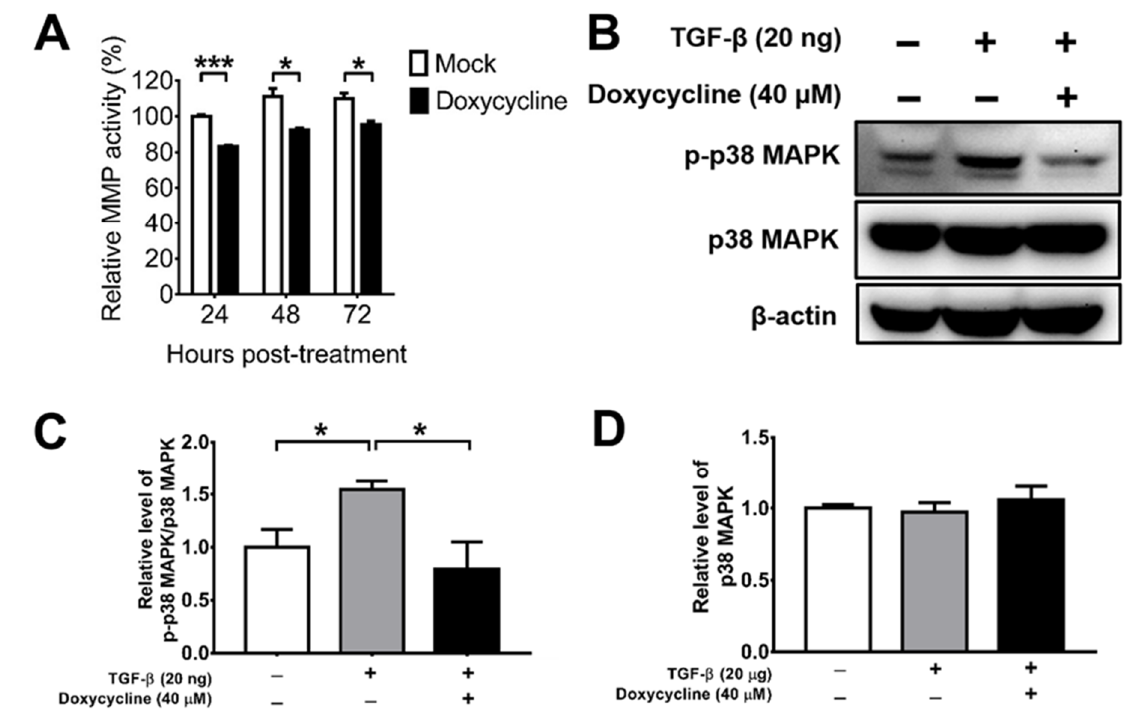
Figure 2. Doxycycline inhibits the total MMP activity and p38 MAPK activation of ARPE-19 cells. ( A ) ARPE-19 cells were treated with or without doxycycline (10 μM) and harvested at the indicated times to assay the total MMP activity. The value of cells without drug treatment for 24 h was set as 100%. ( B ) TGF-β-induced ARPE-19 cells were treated with or without doxycycline (40 μM) for 48 h and assayed for p-p38 MAPK, p38 MAPK, and β-actin via Western blotting. The representative blots ( B ) and quantitated results ( C , D ) are shown. In each sample, the values of p-p38 MAPK and p38 MAPK were normalized to that of β-actin and the value of normalized p-p38 MAPK was divided by that of normalized p38 MAPK. The values of cells without TGF-β and doxycycline treatment were set to 1. The data represent means + SEM (error bars) of ≥3 samples per group. Note: *, p < 0.05 and ***, p < 0.001 via Student’s t test.